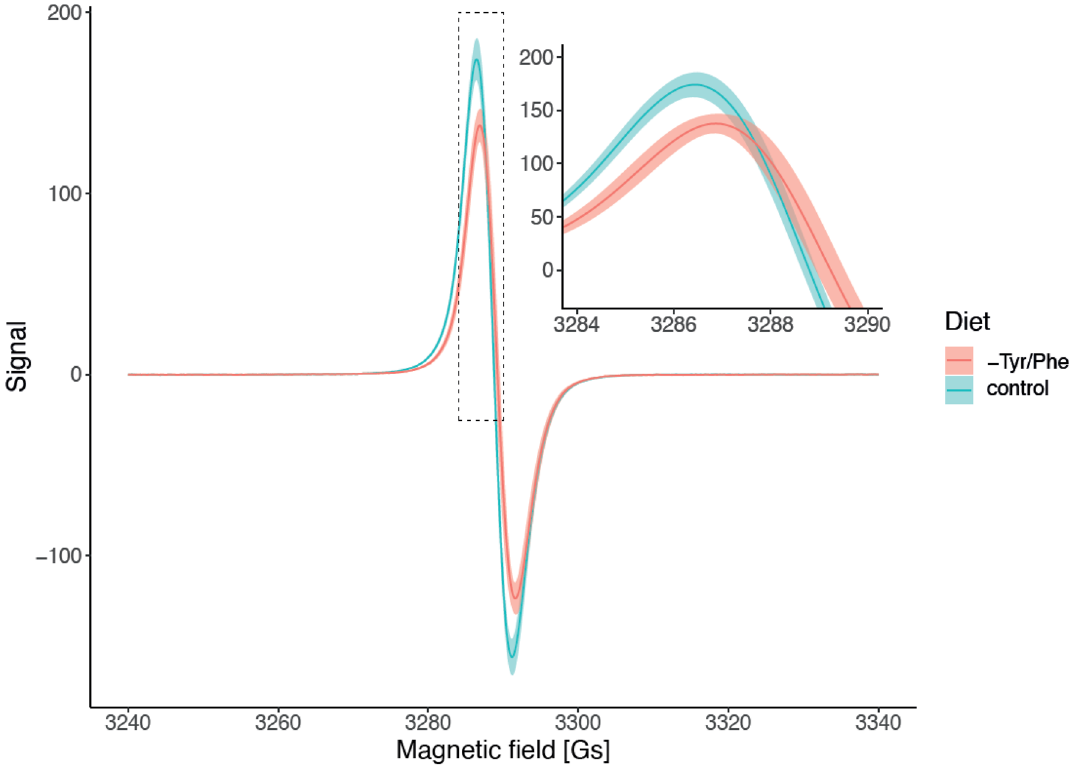
Figure 3. Examples of electron paramagnetic resonance spectroscopy (EPR). The EPR showing quality and quantity of melanin pigments in feather samples obtained from the bib of house sparrows. Each curve was calculated as mean EPR signal from all individuals coming from the same